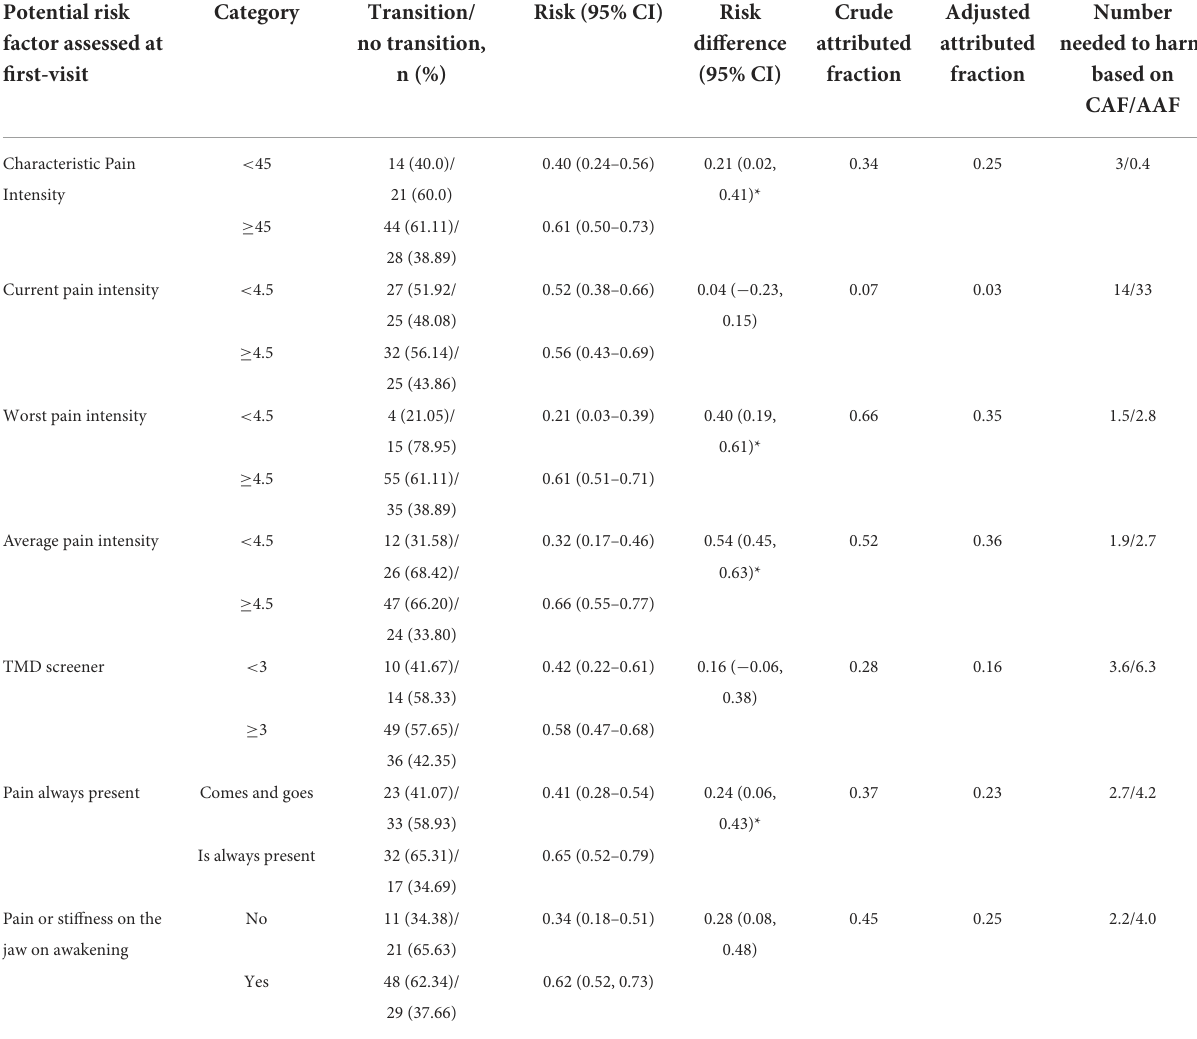
TABLE 3 Risk difference, attributed fraction and number need to harm associated with the transition from acute to chronic pain-related TMD at 3 months of